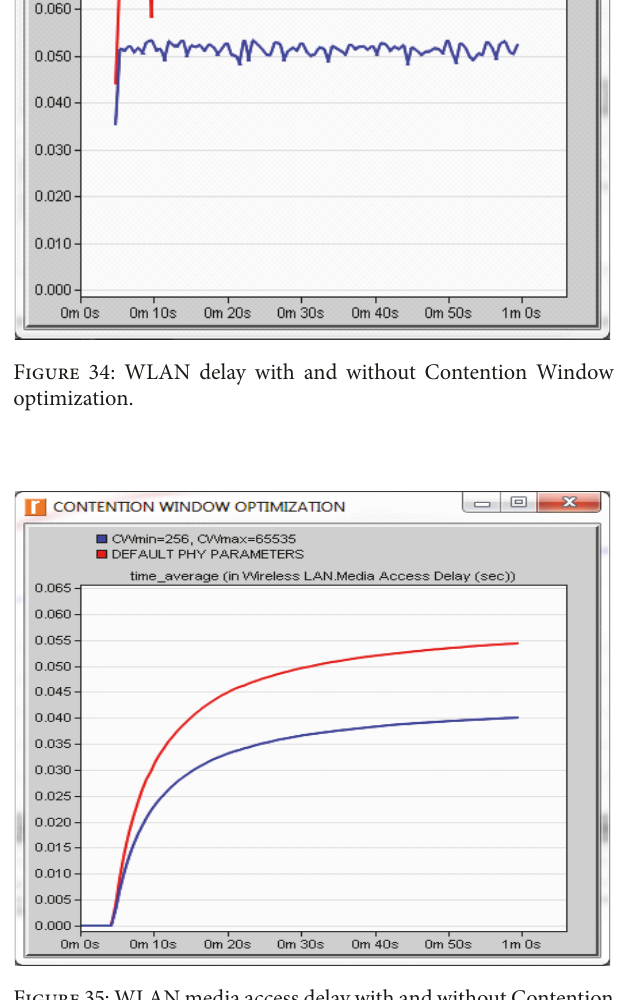
Figure 35: WLAN media access delay with and without Contention Window optimization.